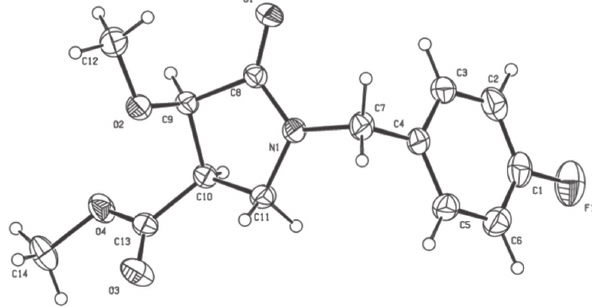
Table 1: Data collection and